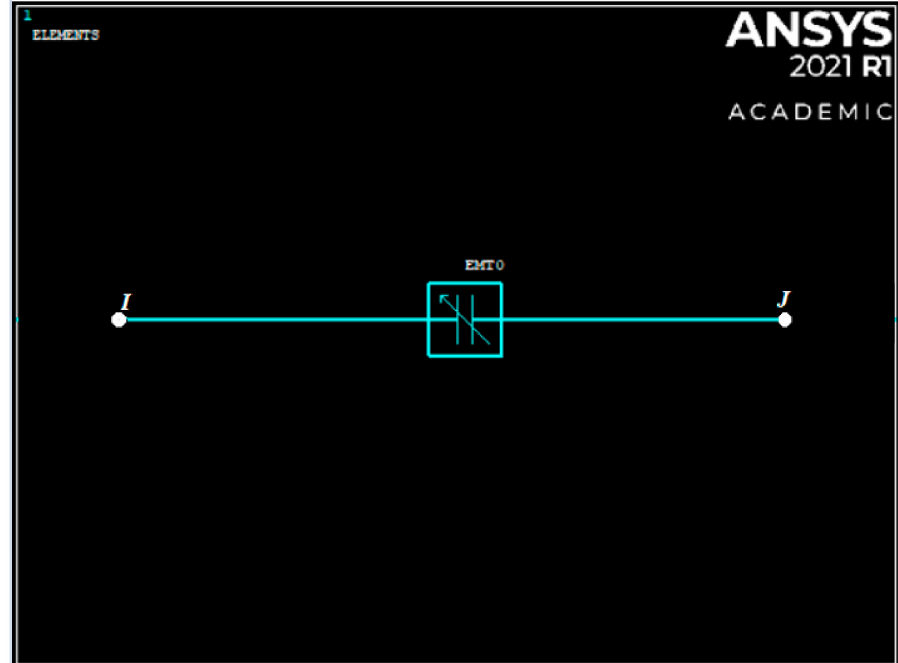
Figure 16. The configuration of a TRANS126 element